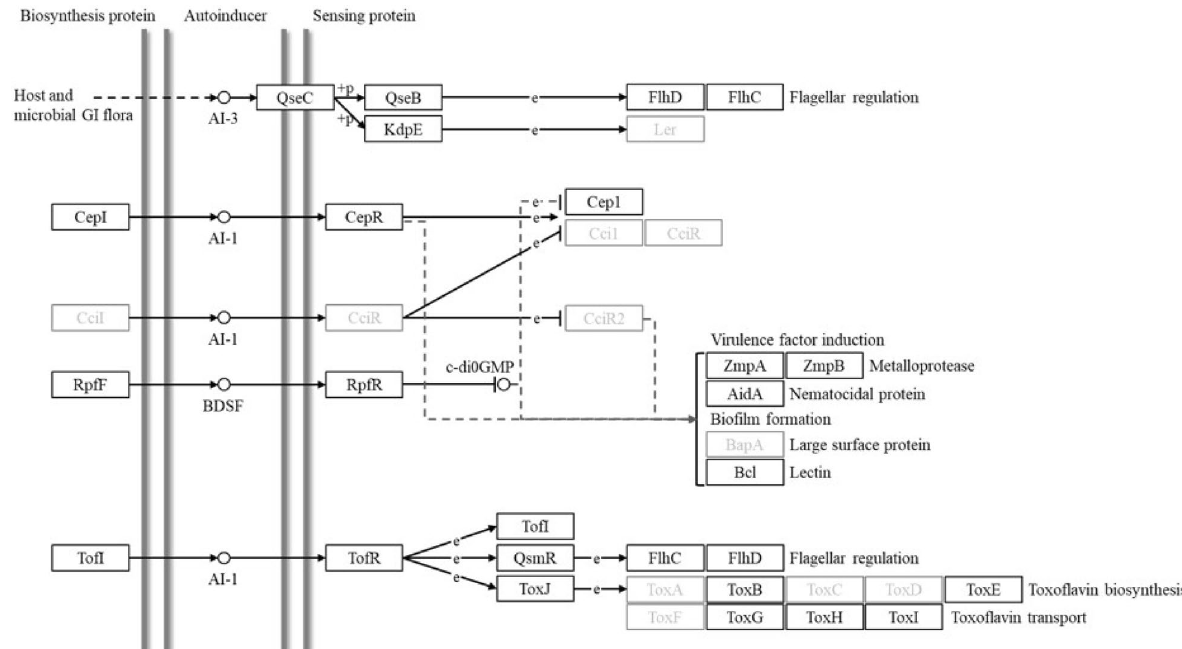
Fig. 4 The Kyoto Encyclopedia of Genes and Genomes (KEGG) pathway for quorum sensing in B. contaminans SK875. The black box proteins and gray box proteins indicate the presence and absence of proteins,